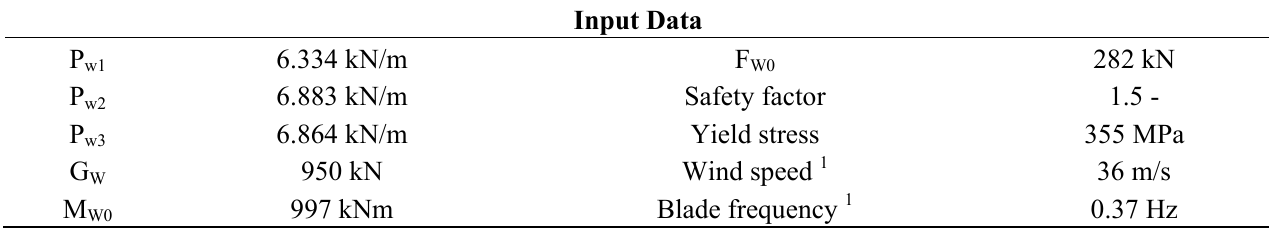
Table 1. An example of numerical data.